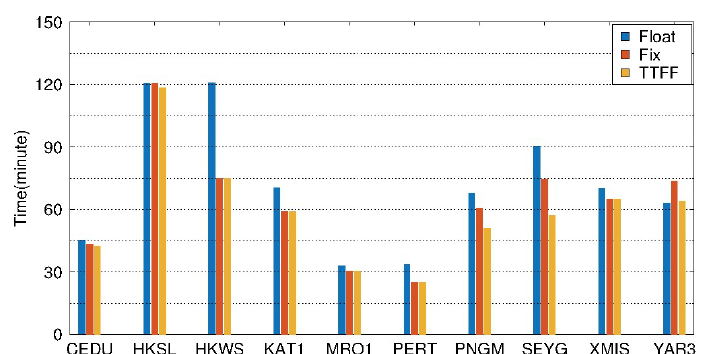
Figure 23. Average convergence time of float and fixed solutions, and TTFFs of 10 selected stations in kinematic PPP processing from DOY 061 to 090, 2018. Table 6. The average accuracy of BDS kinematic PPP for 10 stations (Unit: cm).